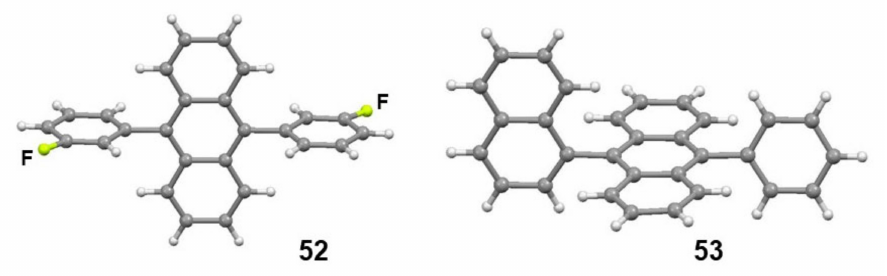
Figure 26. Structures of anti -9,10-di(3-fluorophenyl)anthracene, 52 , and of 9-(1-naphthyl)-10- phenylanthracene, 53